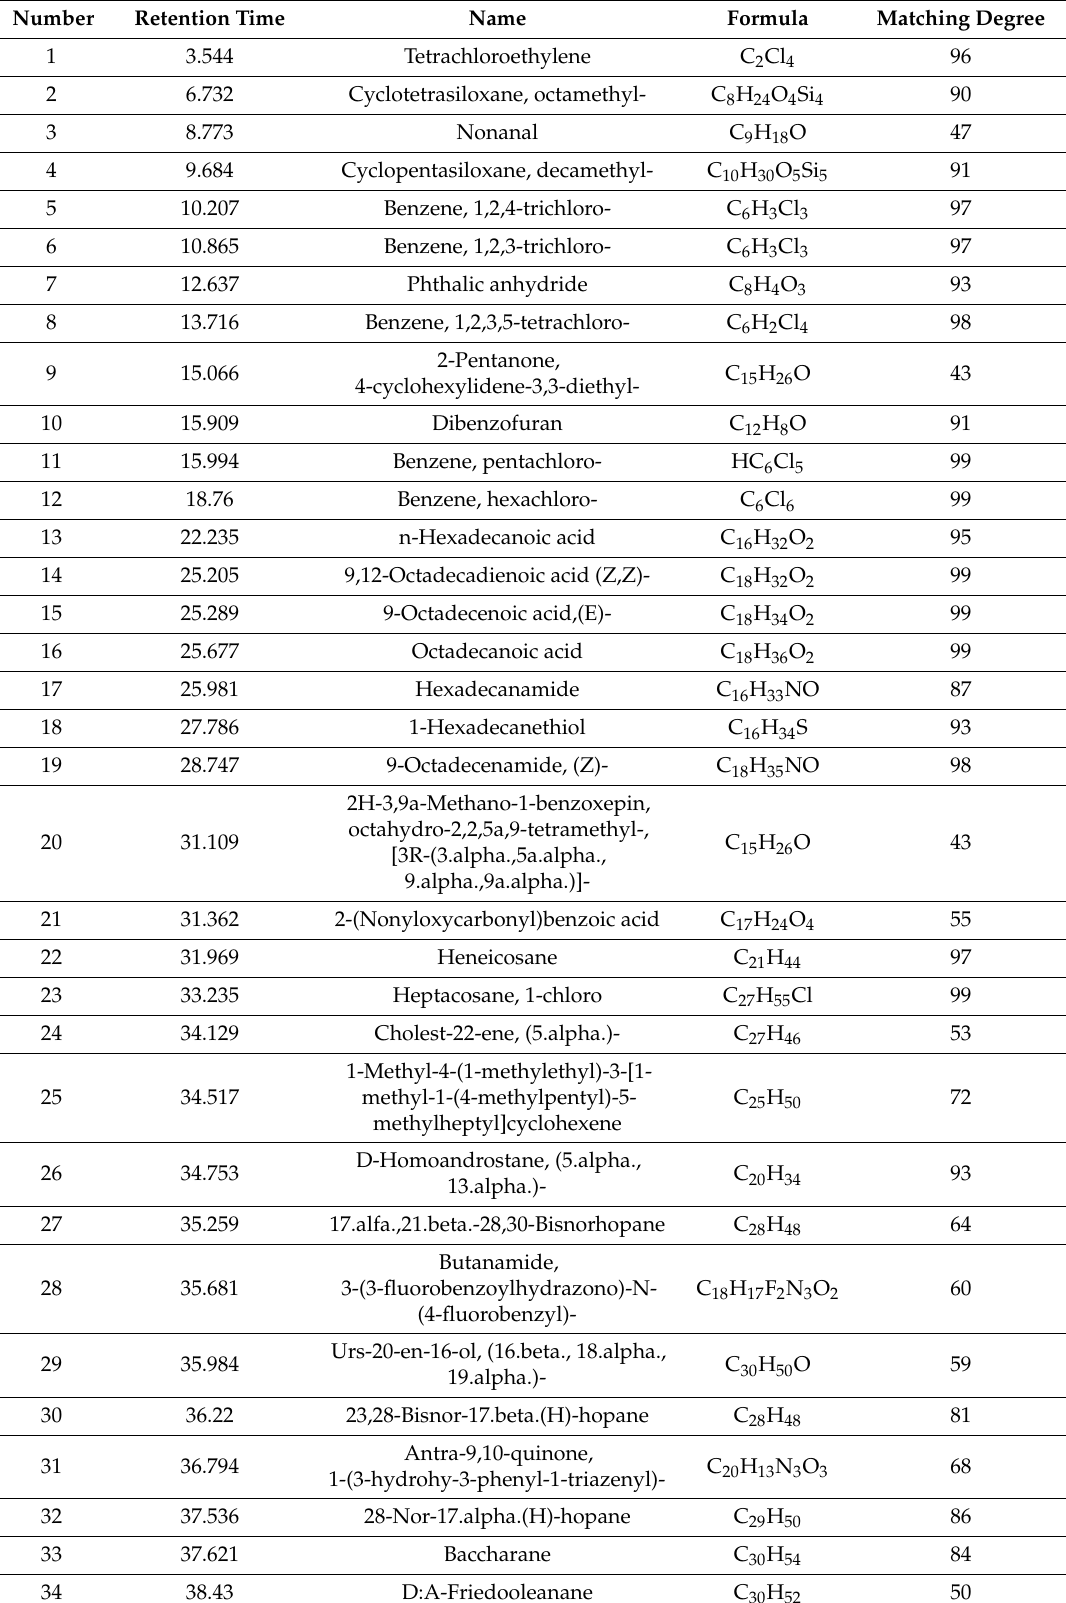
Table 3. Exhaust components absorbed by activated carbon in conventional diesel